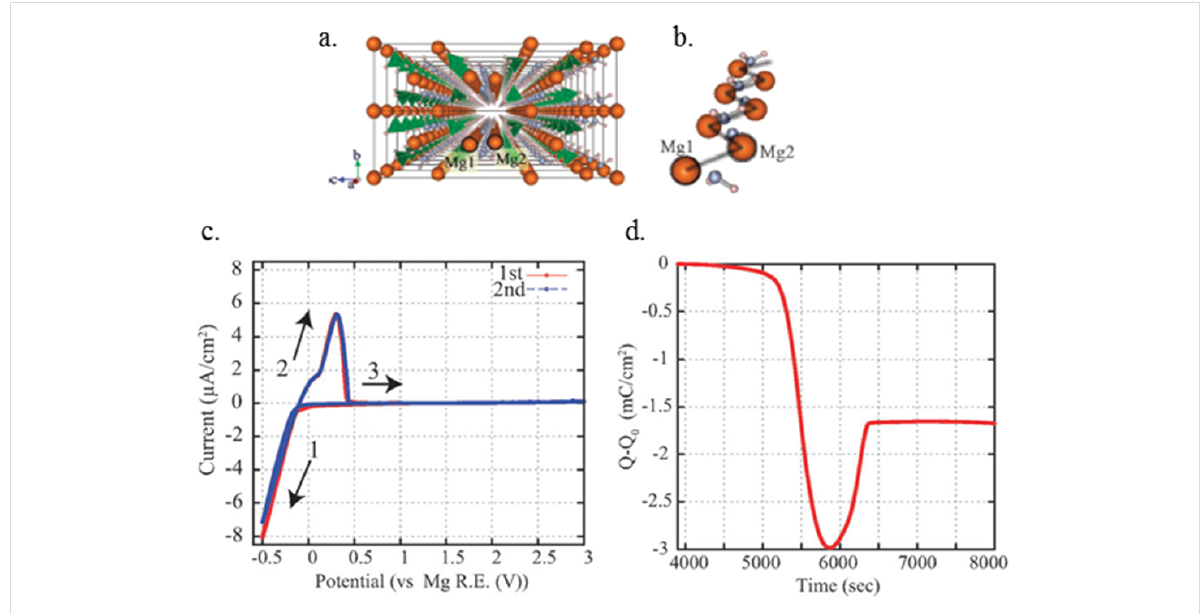
Figure 7: a) Crystal structure of Mg(BH 4 )(NH 2 ). Atomic sizes are depicted by sphere radii. b) Mg zigzag structure from the crystal structure a). c) Cyclic voltammograms of Mg/Mg(BH 4 )(NH 2 )/Pt and, d) deposition/stripping charge balance (first cycle). Reproduced with permission from [37]. Copyright 2012 The Royal Society of